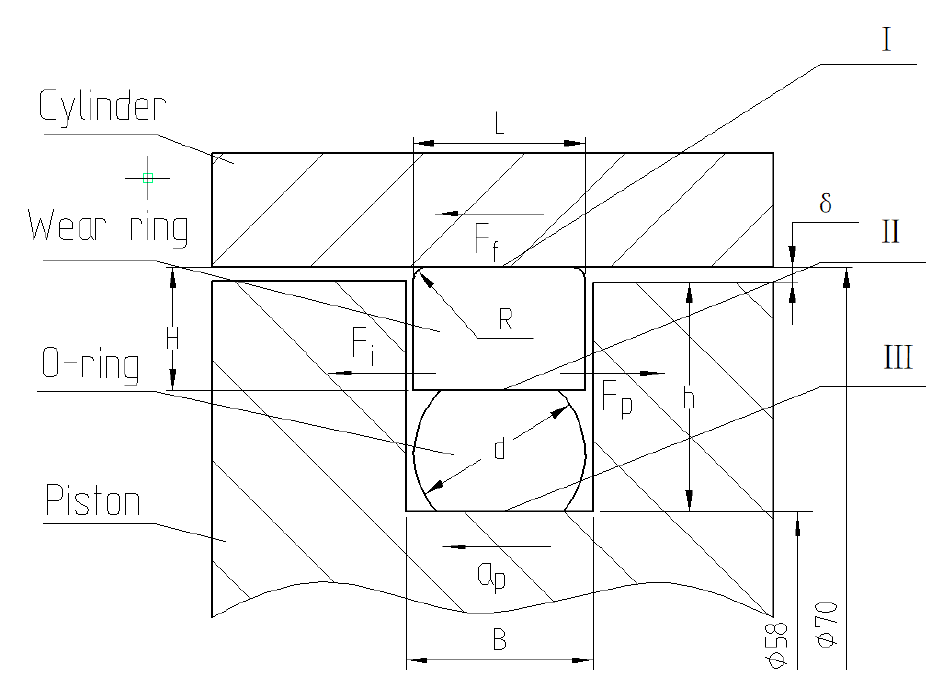
Figure 1. Combined sealing structure and force section view. Table 1. Material table of the hydraulic cylinder and combined sealing